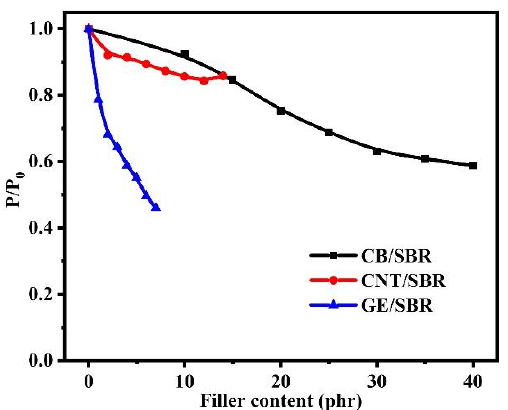
Figure 9. The relative permeability coefficients of SBR composites filled with different contents of CB, CNTs and GE.